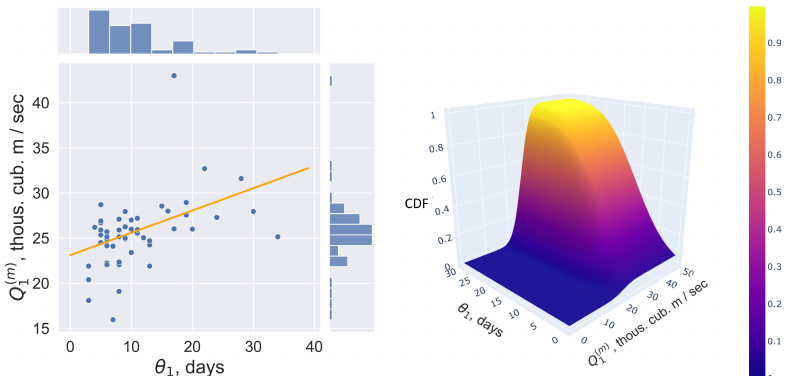
Figure 11. Virtual values, density and distribution function of the first stage parameters of the flood hydrograph through the VHPS for 1962–2021. The orange line shows the linear regression of ( m ) ( θ ) Q 1 1